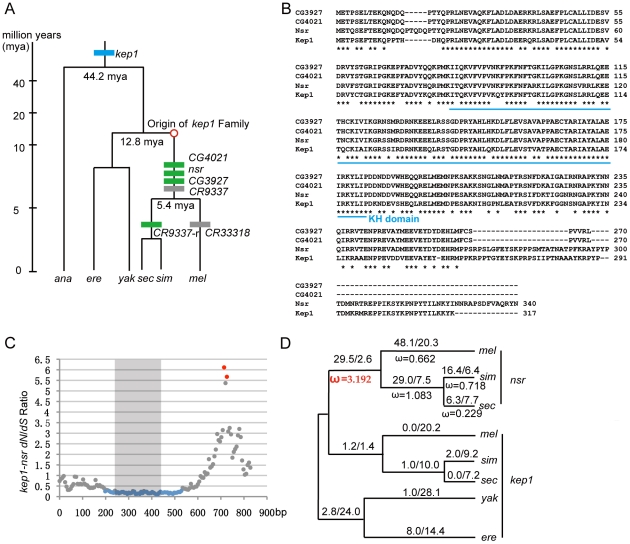
Evolutionary analysis of kep1 family.(A) Origination events of the newly originated kep1 gene family. The phylogeny of the Drosophila species and the divergence time are indicated [18]. On the phylogenetic tree, the blue box represents the parental gene kep1, and green and grey boxes represent the intact new genes and pseudogenes of the kep1 family, respectively. The approximate starting point of the origination of the kep1 family is depicted as a red circle. (B) Multiple alignments for protein sequences of kep1 family genes in D. melanogaster. The asterisks denote the positions of identical amino acids. The blue line under the alignment shows the KH RNA-binding domain. (C) Distribution of dN/dS throughout the kep1-nsr pair. With 120-bp windows and 6-bp slides, dN/dS ratios were estimated using the maximum likelihood method [53] and plotted. Blue and red spots represent dN/dS ratios that are statistically significantly lower and higher than the neutral expectation (p-value <0.05, two-tailed Fisher's exact test), respectively. Regions embedded in the KH domain, as depicted by the grey block, are enriched with signals of purifying selection. (D) Likelihood values of nucleotide substitutions for nsr in Drosophila lineages. Numbers of nonsynonymous and synonymous substitutions for the entire coding sequences are labeled above the lineages, and ω values (dN/dS) are labeled beneath the lineages. A ω value representing the lineage that shows significant evidence of positive selection is highlighted in red. Abbreviations: D. melanogaster (mel); D. simulans (sim); D. sechellia (sec); D. yakuba (yak); D. erecta (ere), and D. ananassae (ana).